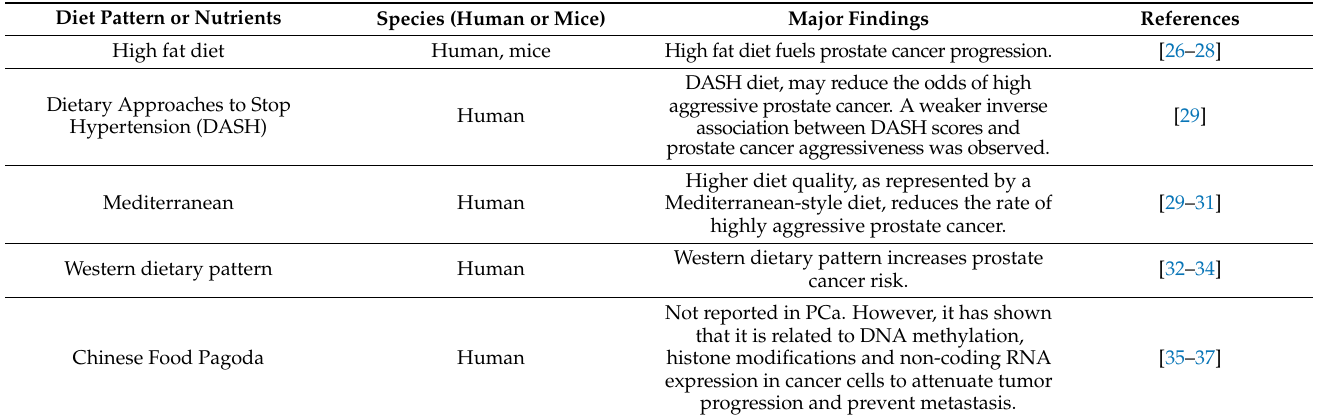
Table 1. Diet patterns and prostate cancer